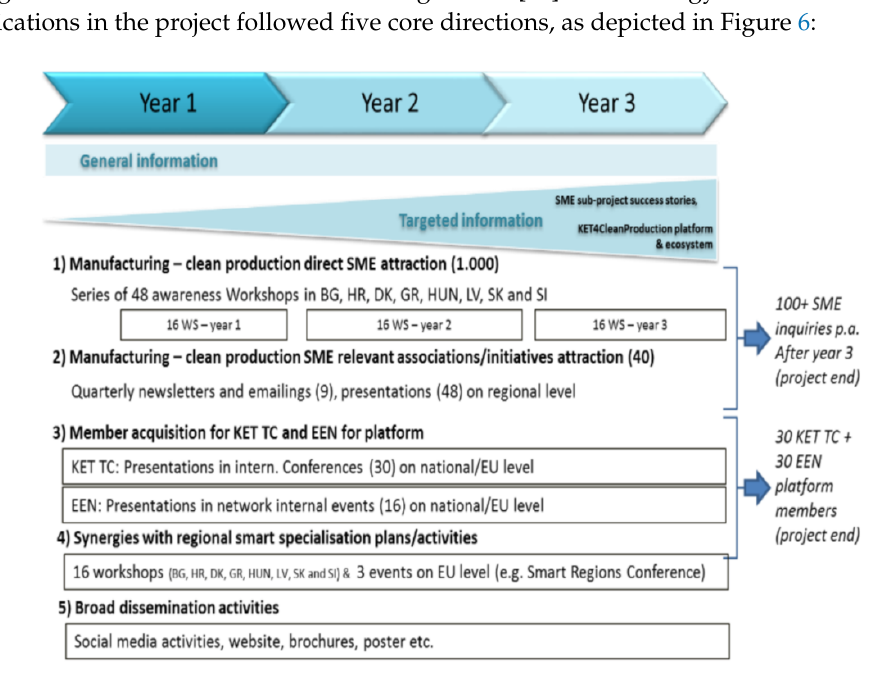
Figure 6. KET4CP dissemination and communication plan .